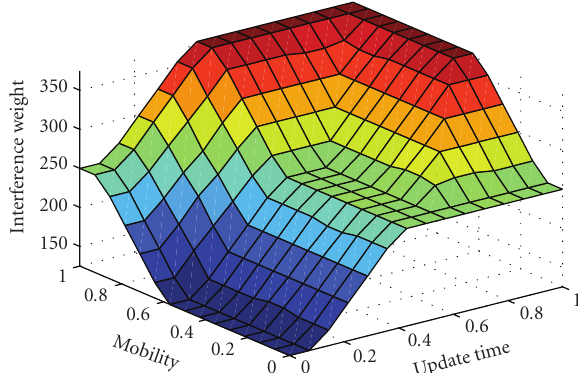
Figure 4: Interference weight as a function of the mobility level and the number of